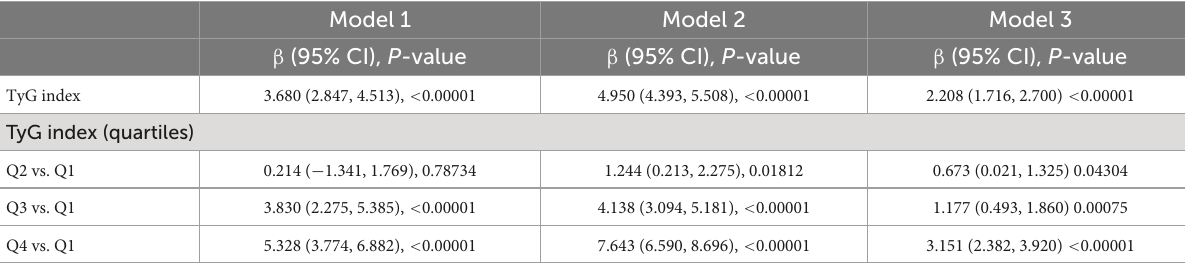
TABLE 2 Linear regression analyses of TyG index and 10-year risk of a first hard ASCVD